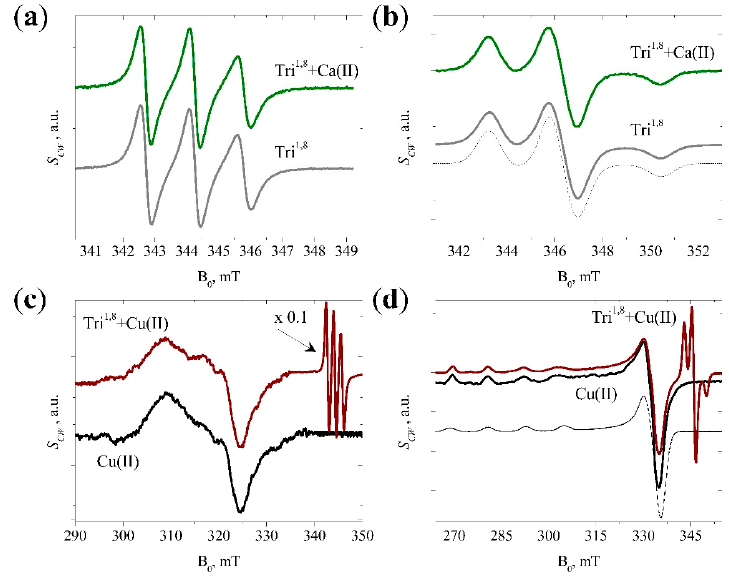
Figure 2. Continuous wave EPR spectra at room temperature ( a , c ) and at 100 K ( b , d ) for the double- labeled peptide Trichogin (Tri 1,8 ) alone and with calcium (Tri 1,8 +Ca(II)) ( a , b ), and for Cu(II) species alone and with double-labeled peptide ( c , d ). Experimental data are shown by solid lines, while dashed lines are simulations for Tri 1,8 , and Cu(II),